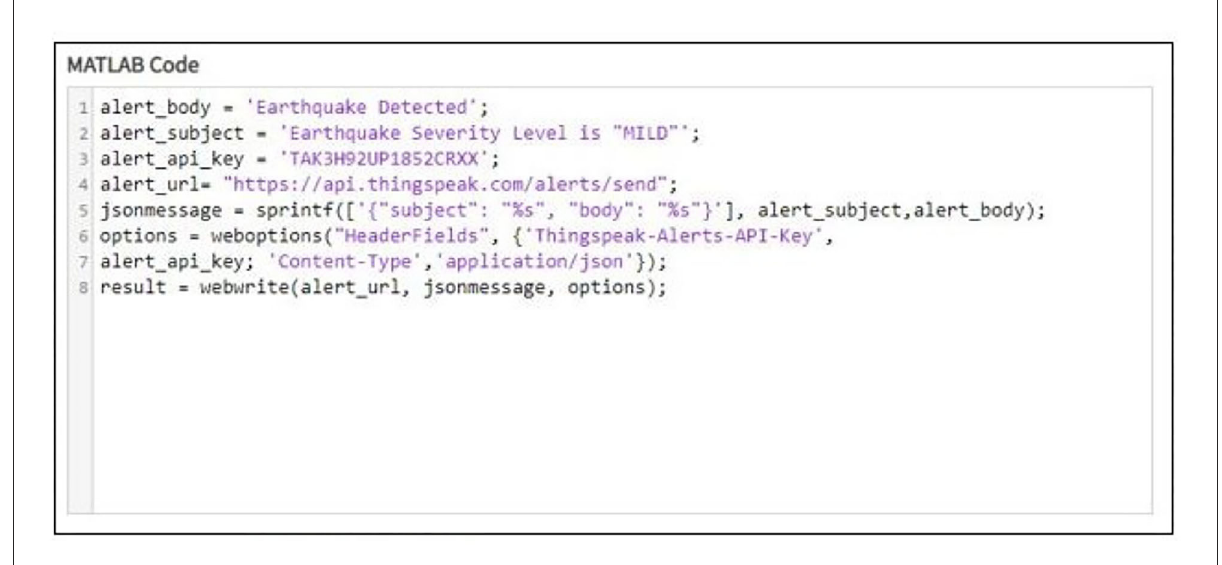
about the situation, but it also depends on their intentions to